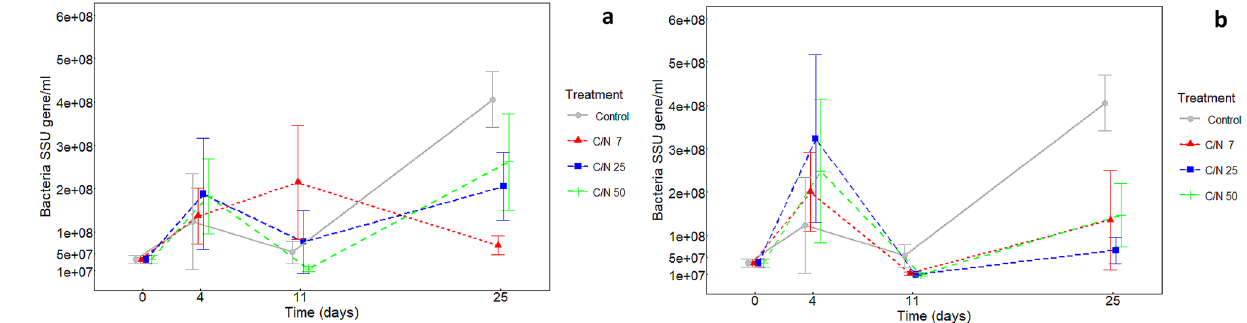
Figure 3. Bacteria SSU gene (per ml) in control samples and samples amended by artificial exudates with different C/N ratios ( A ) in concentration of 2% of total DOC and ( B ) in concentration of 5% of total DOC during 25 days incubation (means, ± standard deviations, n =